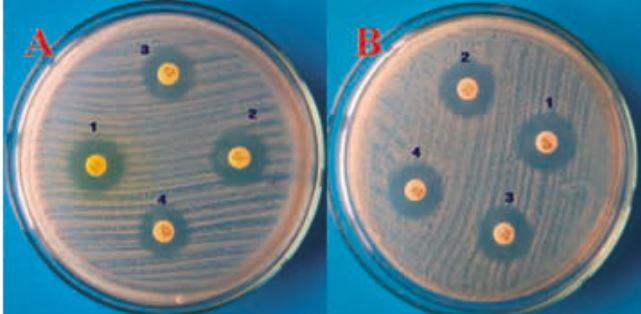
Fig. 1. Antibiogram of S. aureus (A)- antibiogram showing different combinations of enrofloxacin with berberine (B)- antibiogram showing different combinations of enrofloxacin with capsaicin. 1→ 8 g/L, 2→ 4 g/L, 3→ 2 g/L, and 4→ 1 g/L